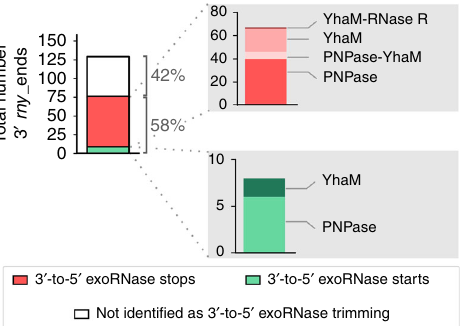
Fig. 2 3 ′ -to-5 ′ exoRNases trim RNAs generated by RNase Y processing. Left bar plot: portion of RNA 3 ′ ends (3 ′ rny _ends) corresponding to 3 ′ -to-5 ′ exoRNase start positions (bottom portion), 3 ′ -to-5 ′ exoRNase stop positions (middle portion) and not associated with 3 ′ -to-5 ′ exoRNase (top portion). Right bar plots: number of trimming starts (top) and stops (bottom) that correspond to 3 ′ rny _ends, which were uniquely produced by PNPase and YhaM or produced by two different 3 ′ -to-5 ′